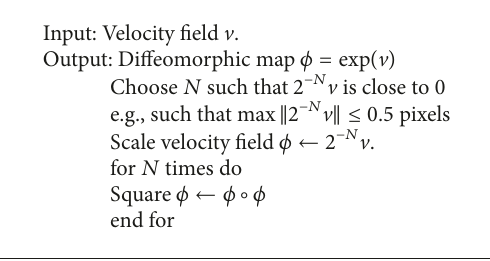
Algorithm 1: Exponential 𝜙 = exp ( V )